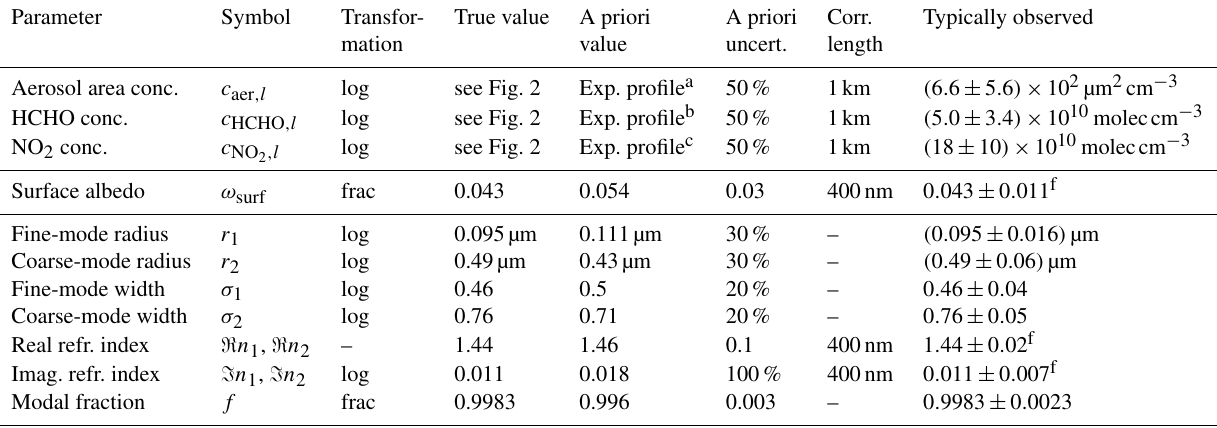
Table 4. Settings for state vector elements x used in this study. The “true values” column indicates the values applied for the forward simulation of synthetic observations. Values for surface albedo and aerosols were adapted from Dubovik et al. (2002). Typically observed values for trace gas concentrations were derived from data presented in Tirpitz et al. (2021). Remaining columns enumerate the a priori settings used for the inversion procedure.